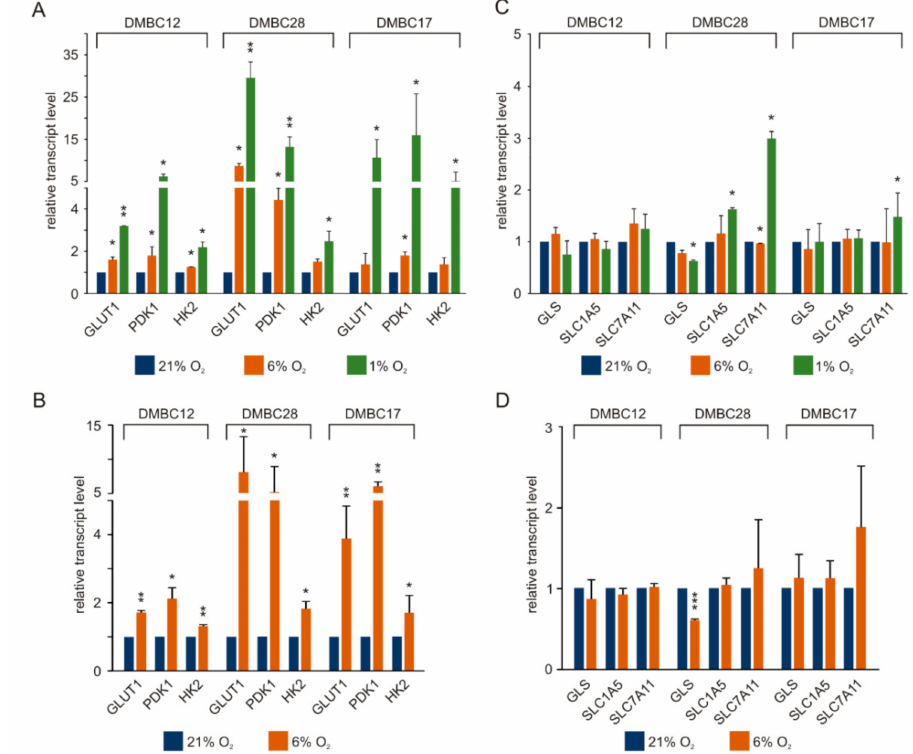
Figure 3. Normoxia stimulates the expression of genes associated with glucose metabolism and to the lower extent with glutamine metabolism in cell line-dependent manner. ( A ) Transcript levels of GLUT1 (glucose transporter 1), PDK1 (pyruvate dehydrogenase kinase 1) and HK2 (hexokinase 2) in melanoma cells incubated in the presence of 21% O 2 , 6% O 2 or 1% O 2 for 24 h were determined by qRT-PCR and normalized to the expression of a reference gene RPS17. Gene expression in 6% O 2 and 1% O 2 is presented relative to the expression in 21% O 2 . ( B ) Transcript levels of GLUT1, PDK1 and HK2 in melanoma cells cultured in the presence of 6% O 2 for at least 3 weeks (established 6% O 2 culture) relative to their levels in cells cultured in 21% O 2 . ( C ) Transcript levels of GLS (glutaminase), SLC1A5 (solute carrier family 1 member 5) and SLC7A11 (solute carrier family 7 member 11 transporter) in melanoma cells after 24 h incubation in 21% O 2 , 6% O 2 and 1% O 2 , or ( D ) in the established 6% O 2 culture, relative to their levels in 21% O 2 . Bars represent mean values of 3-4 biological replicates ± SD. Di ff erences are considered significant at * p < 0.05, ** p < 0.01 or *** p <